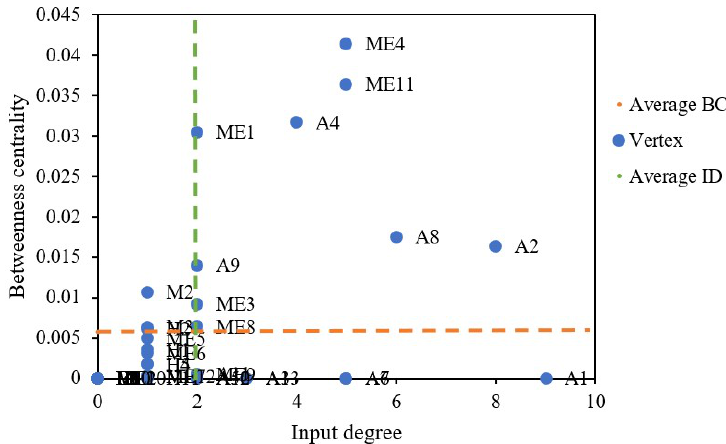
Figure 10. Input degree and betweenness centrality. Betweenness centrality (BC), output degree (OD) and their average values (green and orange dotted lines) are illustrated in Figure 11. Improper operation and maintenance of equipment and facilities (ME1) and signal failure (ME4) have high values of BC and OD. This indicates that these two causative factors could quickly induce the occurrence of other risks. The onsite safety management personnel should give sufficient focus to these specific safety risks. Applying these results may enhance the management level of risk sources, significantly decreasing the probability of subway operation accidents.